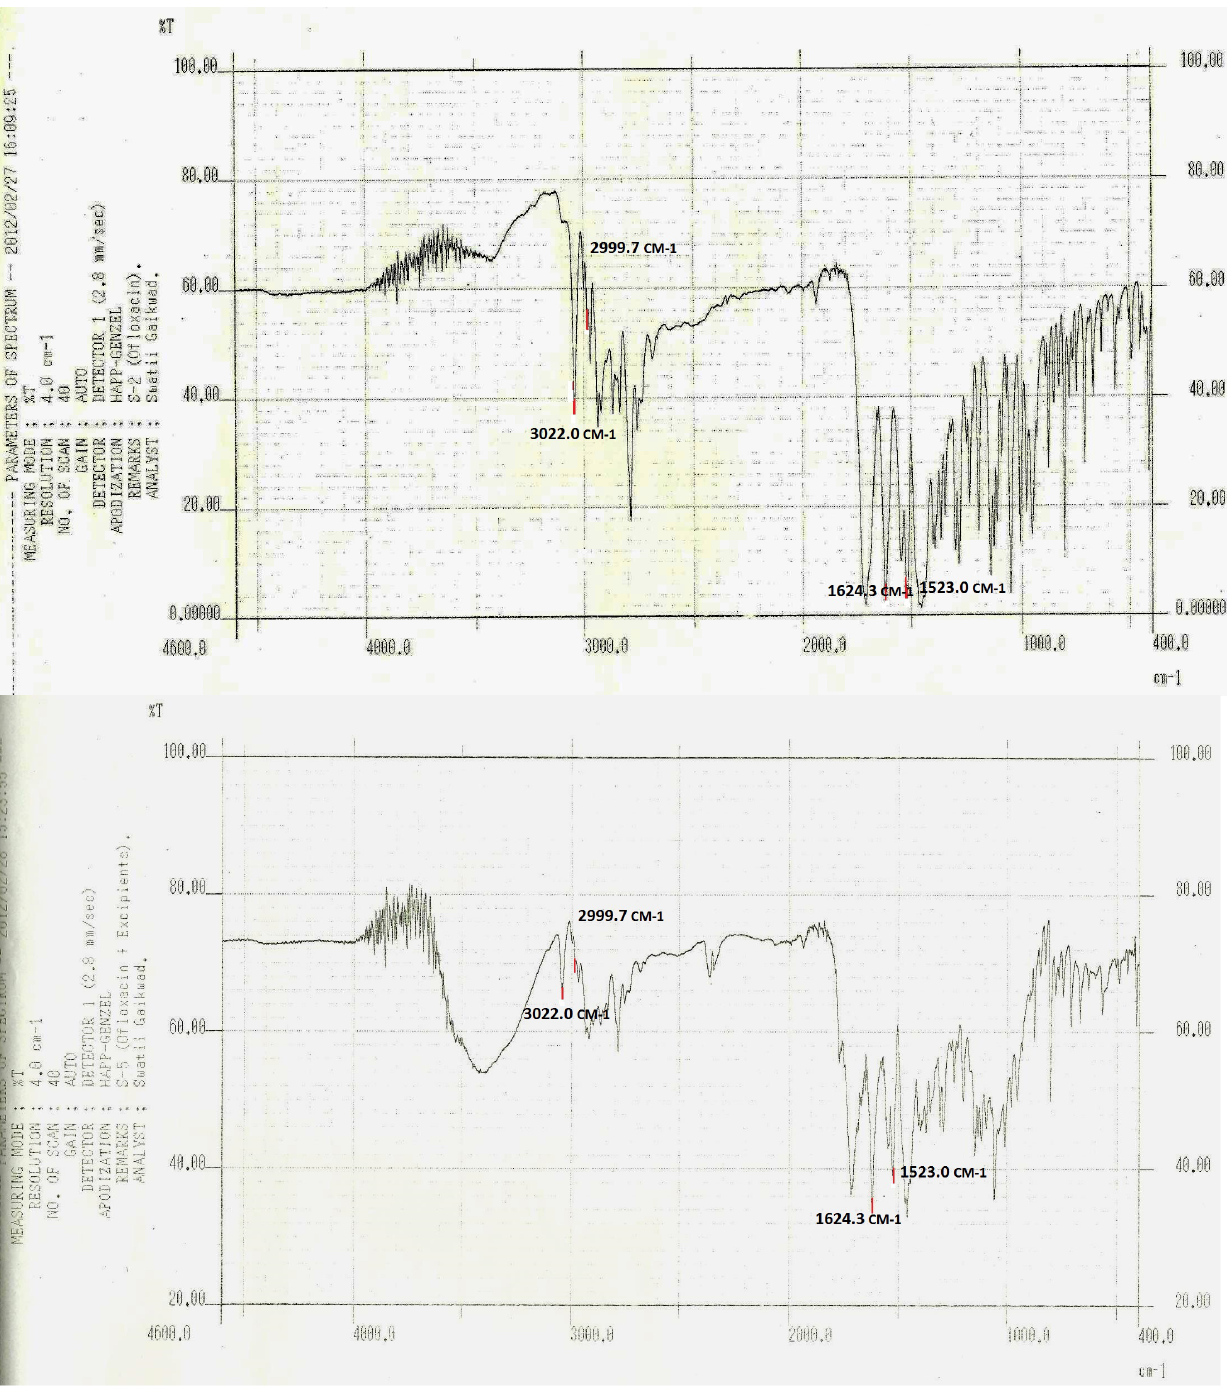
FIGURE 2 - Infra red (FT-IR) spectrum of ofloxacin and ofloxacin with excipients. physical parameters were also found to be stable after a three month stability study (Table